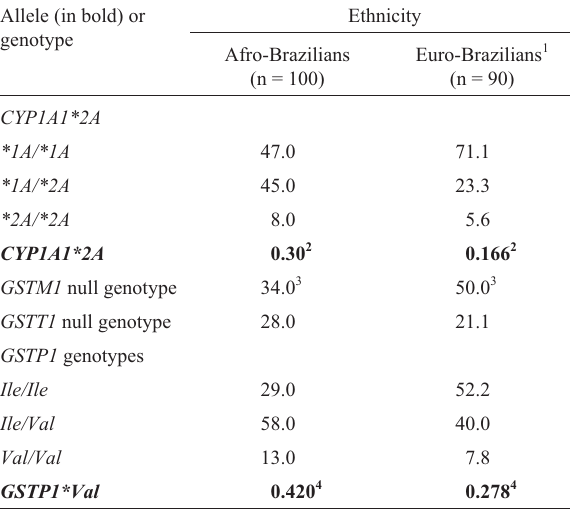
Table 1 - The CYP1A1 , GSTM1 , GSTT1 and GSTP1 genotype and allele frequencies (%) in Euro-Brazilians and African-Brazilians from Porto Alegre, Rio Grande do Sul, Brazil. Allele frequencies are shown in